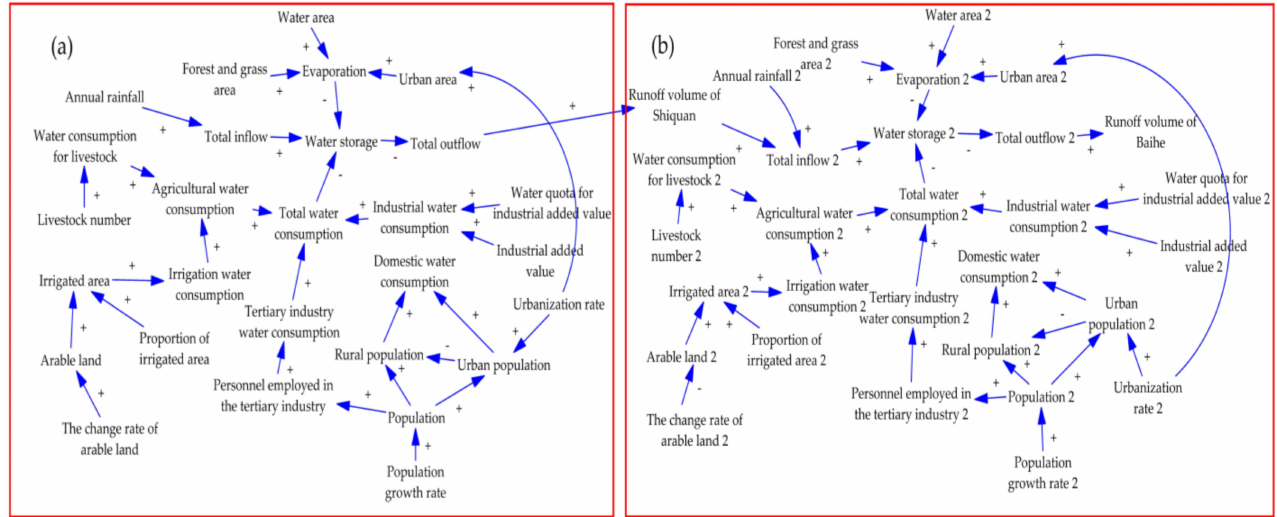
Figure 2. Causal loop diagram of socio-hydrological system: ( a ) the Upper section; ( b ) the Lower